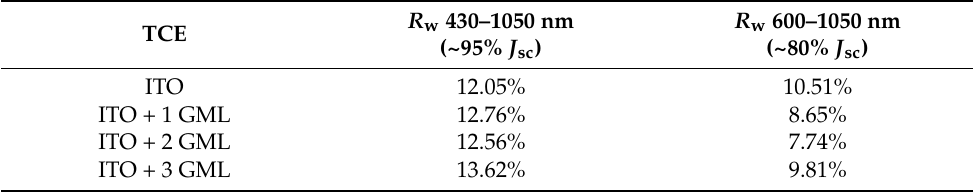
Table 1. Weighted reflectance calculated from the spectra shown in Figure 2 in two different wavelength ranges. The range between 430–1050 nm is relevant because it represents around 95% of the photogenerated current; the range between 600–1050 nm is the range where the hybrid TCE is clearly better in terms of antireflectance properties, and it accounts for around 80% of the photogenerated current. TCE